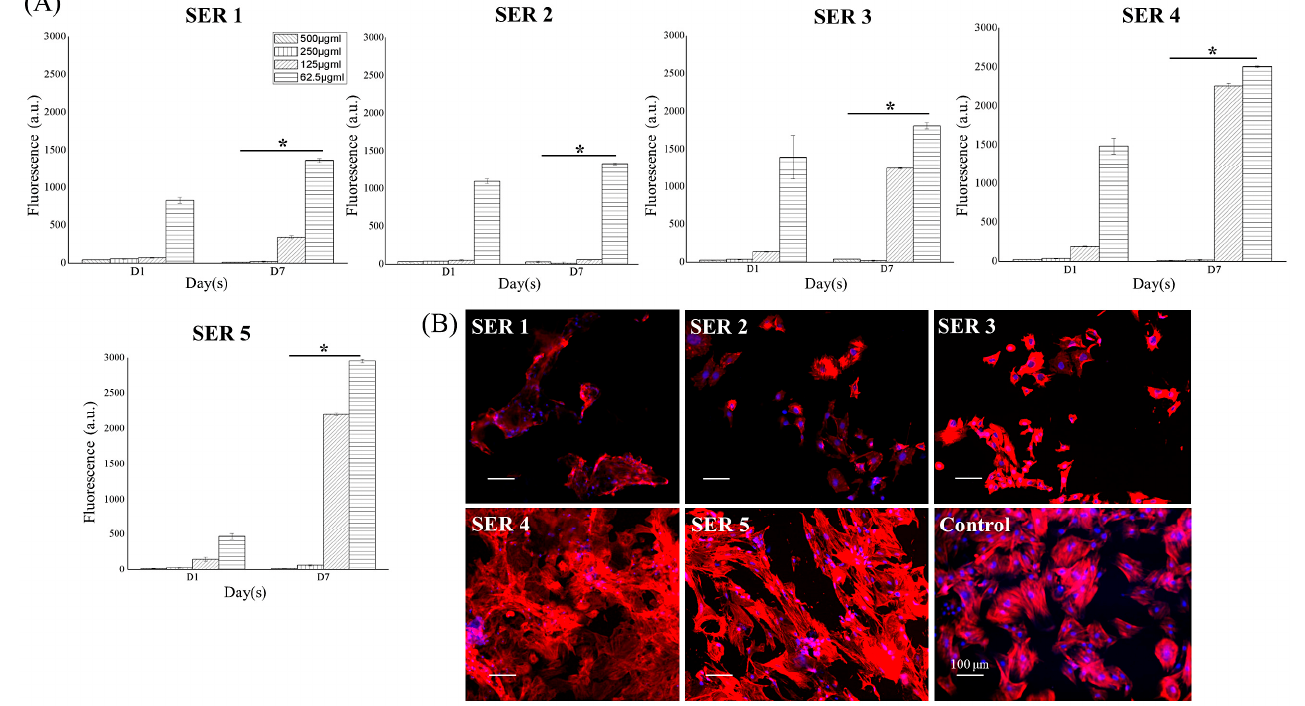
Figure 4. ( A ) Concentration-dependent viability of hASCs after treatment with different dilutions of Cu-SER MOFs. * p < 0.1. ( B ) Cytoskeleton staining of hASCs after treatment with MOFs for 7 days. Actin filaments are stained with phalloidin (red) and nuclei are in blue. Scale bar = 100 µ m.